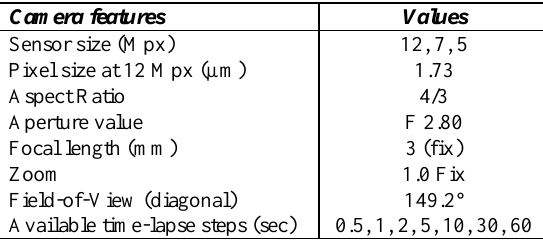
Table 1. Main technical properties of GoPro 4 Black ®